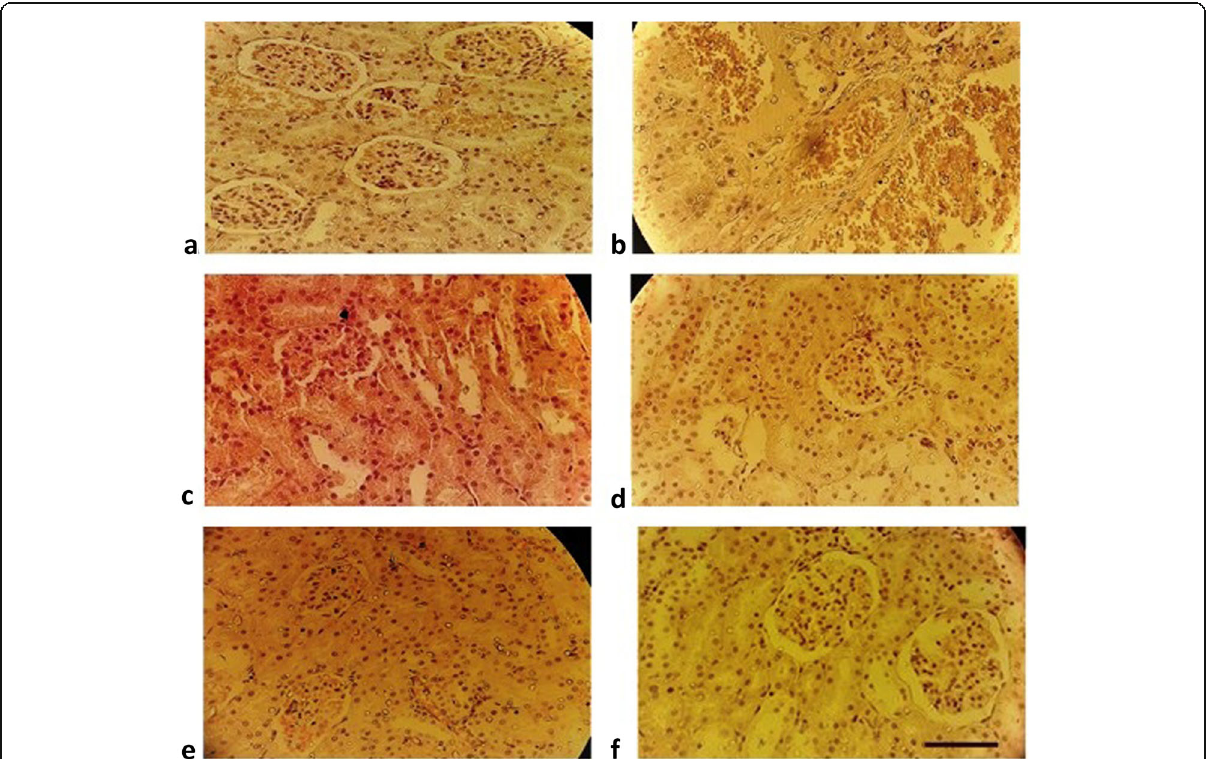
Fig. 4 Histopathology of kidney. Each picture is a representative for each group as follows: a = Healthy control, b = Diabetic control, c = Diabetic control + 10 mg/kg of gliclazide, d = Diabetic control + 100 mg/kg CRME, e = Diabetic control + 200 mg/kg CRME, f = Diabetic control + 400 mg/kg CRME. Each group was evaluated at 400 x magnification, scale bar: 40 μ